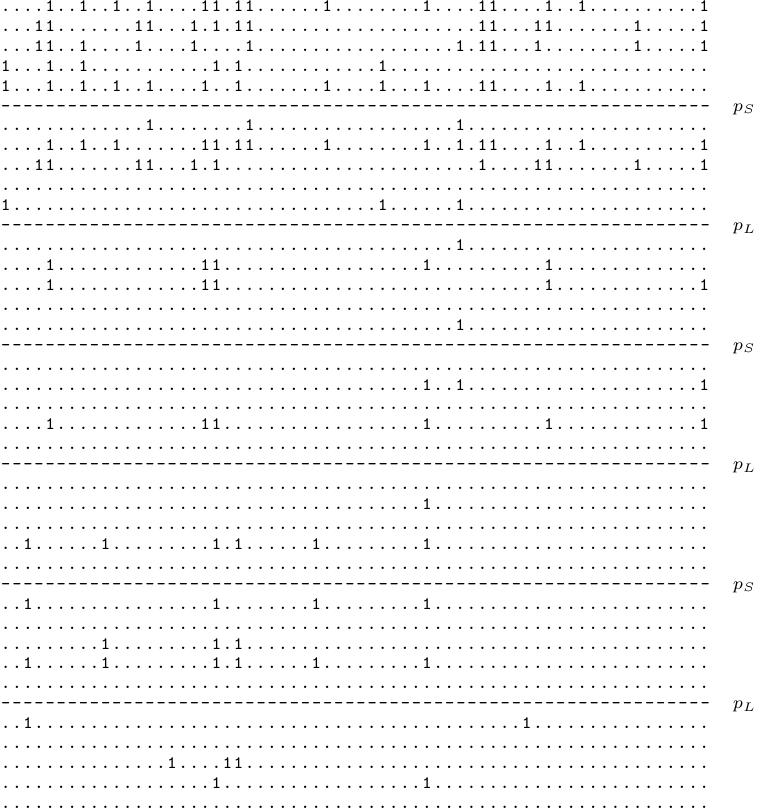
Figure 12: 4-round linear trail with 43 [23, 7, 6, 7] active Sboxes and correlation 56 [30 9 10